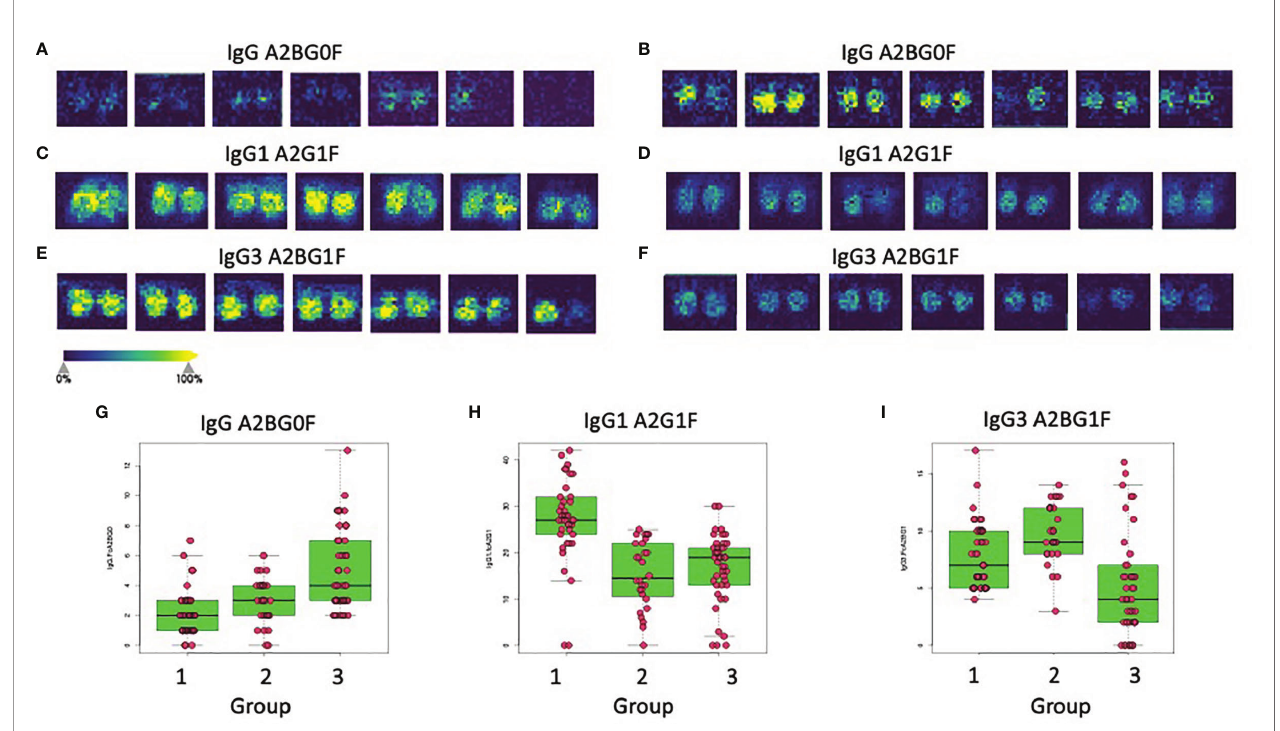
FIGURE 3 | Glycan alterations on immunoglobulins correlate with the level of liver fi brosis. Panels A and B show the imaging analysis for the A2BG0F glycan on IgG from either Group 1 patients (A) or Group 3 patients (B) . (C, D) show the imaging analysis for the A2G1F glycan on IgG1 from either Group 1 patients (C) or Group 2 patients (D) . (E, F) show the imaging analysis for the A2BG1F glycan on IgG3 from either Group 1 patients (E) or Group 3 patients (F) . Panels G, H, and I show box and whiskers plots of the IgG A2BG0F glycan (G) , the IgG1 A2G1F glycan (H) , or the IgG3 A2BG1F (I) glycan in all patients from all three